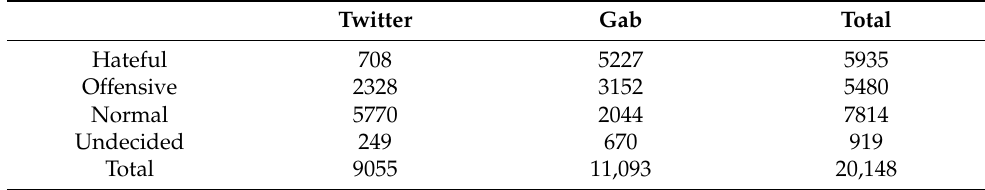
Table 3. HateXplain dataset